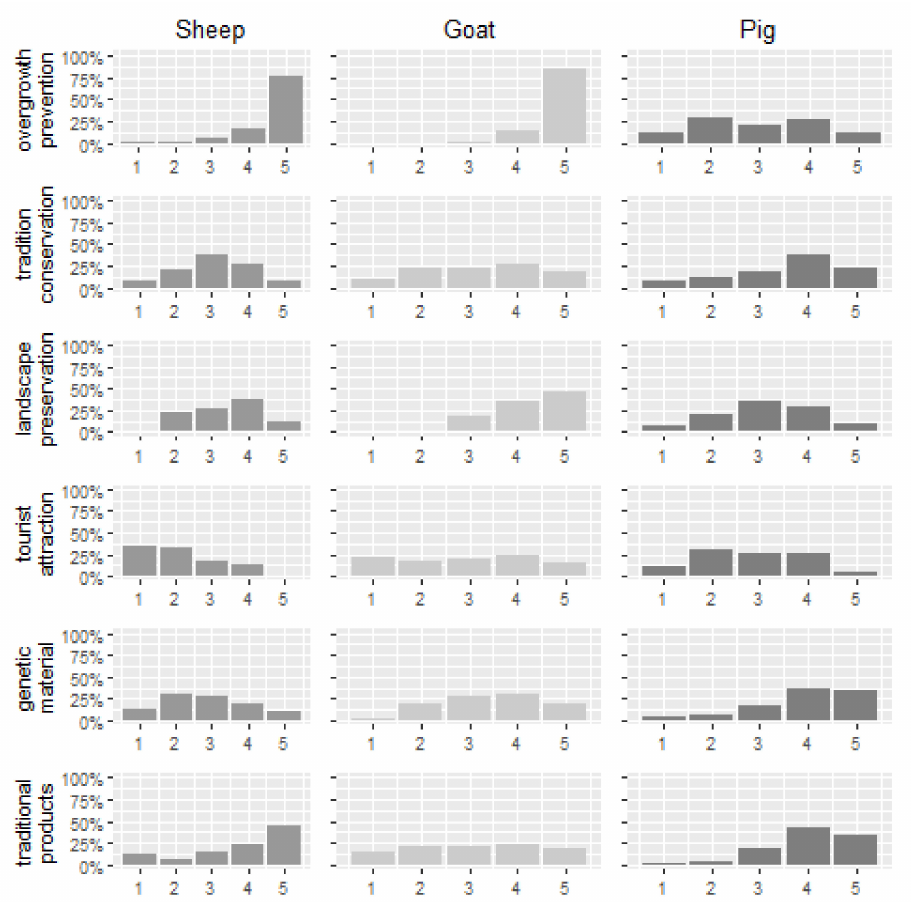
Figure 1. Farmer perceived environmental and social benefits of local breeds (Scale: 1—not important, 5—most important).